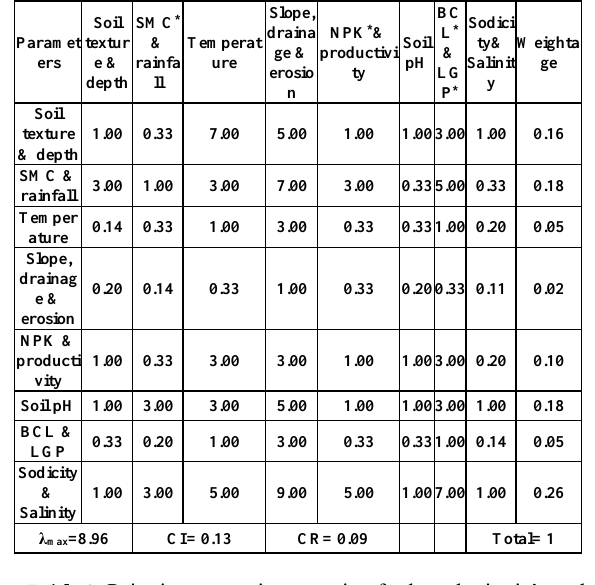
Table 8. Pairwise comparison matrix of selected criteria’s and their weights for Sorghum Parameter s